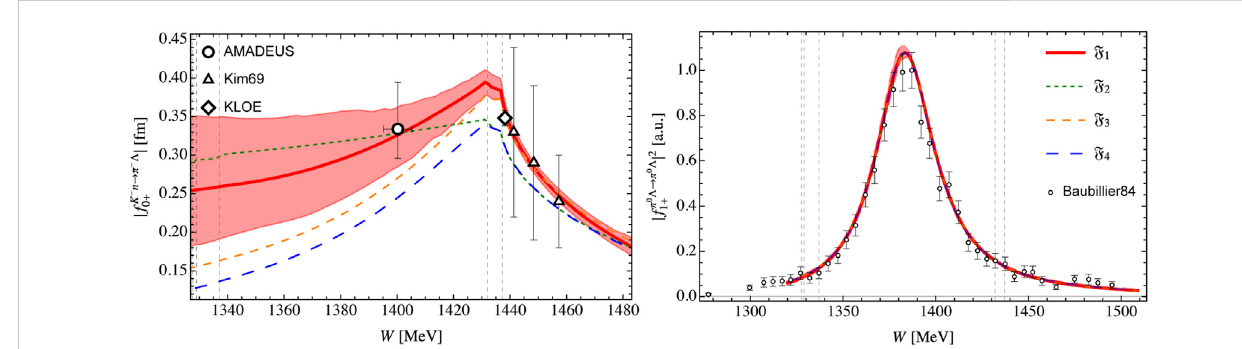
FIGURE 2 Comparison ofthebest fi tresults to thenew data.Differentline-shapes correspond to fi t strategies F 1 − 4 with1 σ bandplottedonlyfor theall-data fi t F 1 . Experimental results are represented by the black empty symbols referring to Baubillier84 [60], AMADEUS [58], KLOE [59] and Kim69 [73]. The latter two measure cross sections and are included as such into the corresponding fi ts. In the fi gure, those are used to estimate partial-waves amplitudes (assuming isospin symmetry and S-wave dominance) to guide the eye.